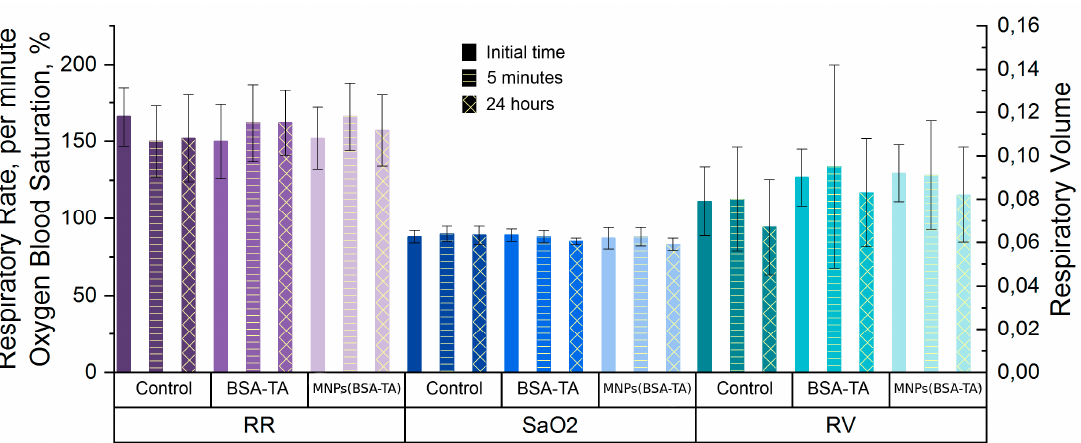
Figure 10. The e ff ect of microcarriers on the respiratory system function. RR—respiratory rate, Figure 10. The effect of microcarriers on the respiratory system function. RR—respiratory rate, SaO2—oxygen blood saturation, RV—respiratory volume. No e ff ect of the carriers on respiratory SaO2—oxygen blood saturation, RV—respiratory volume. No effect of the carriers on respiratory system function was observed. system function was observed.